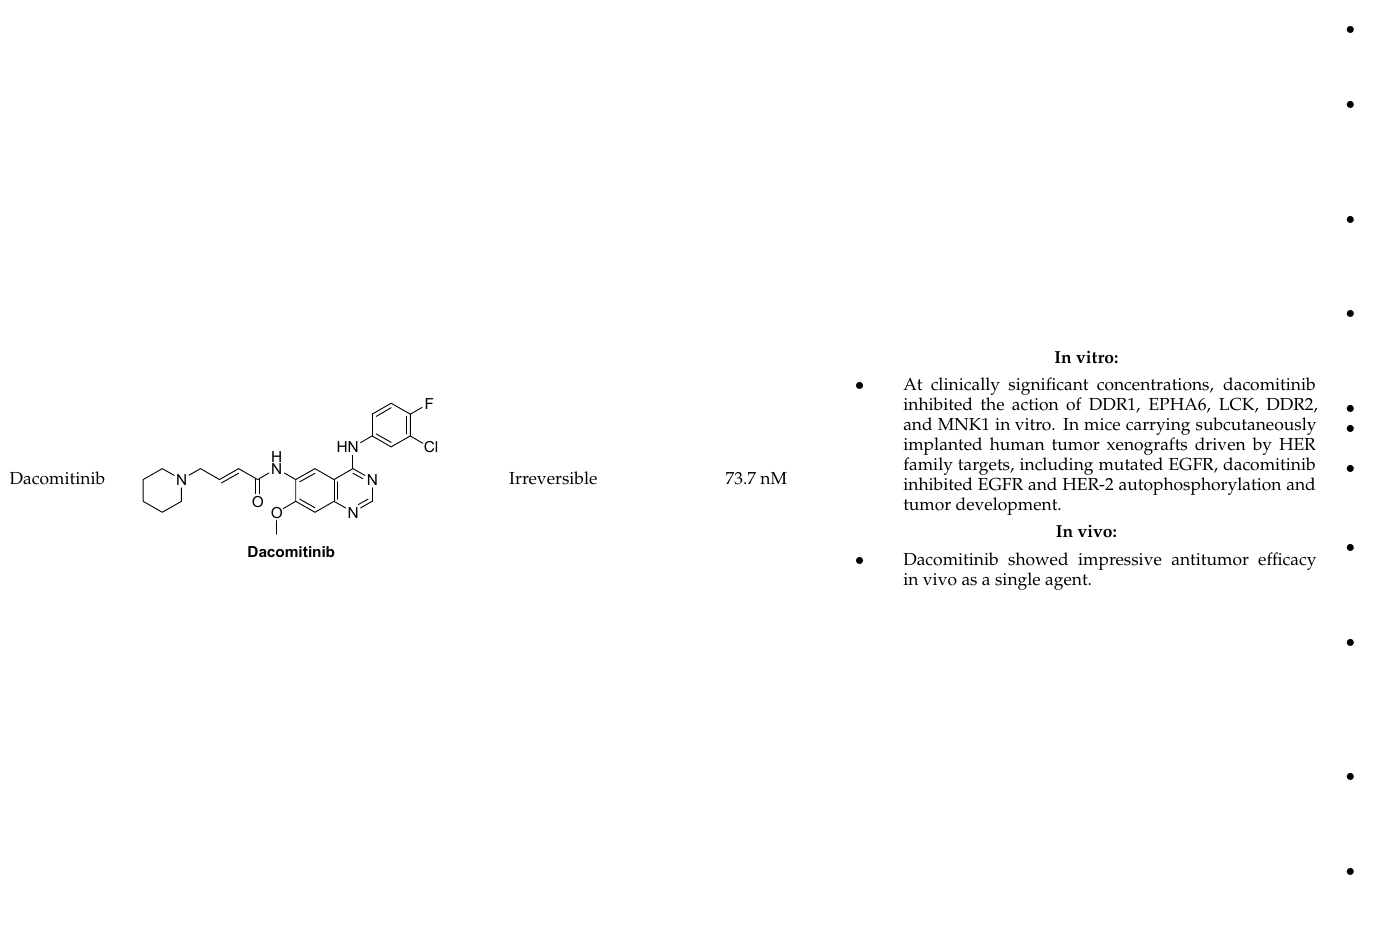
mutation positive advanced NSCLC.